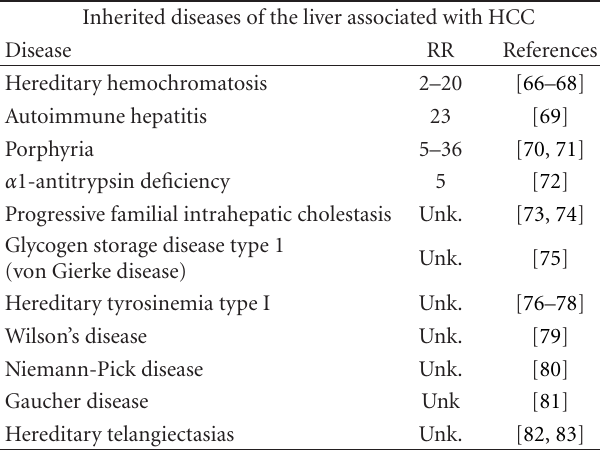
Table 5: Inherited diseases of the liver associated with HCC. Inherited diseases of the liver associated with HCC